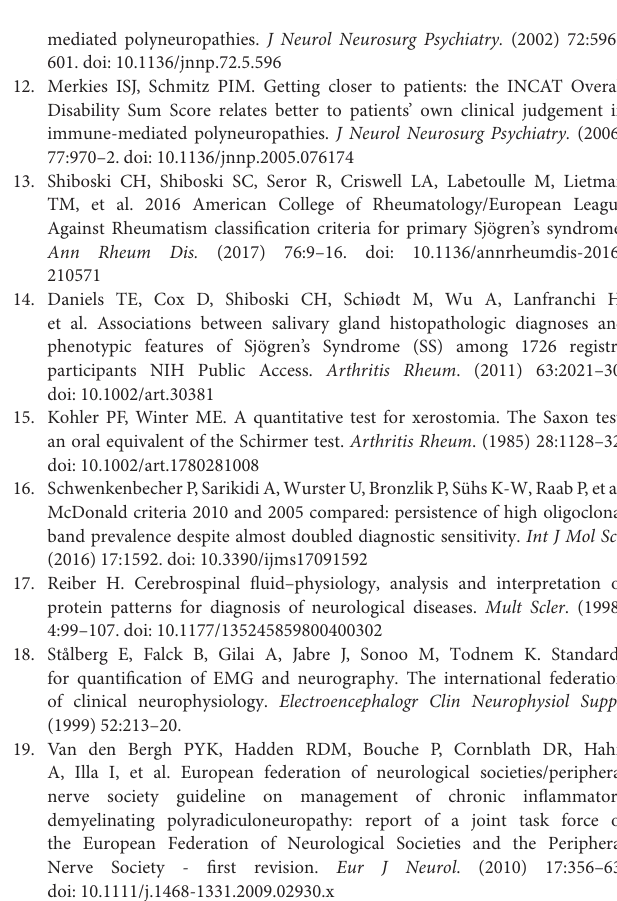
Supplementary Table 1 | Applied electrophysiological classification criteria for nerve damage patterns. Supplementary Table 2 | Extended immunological serologic